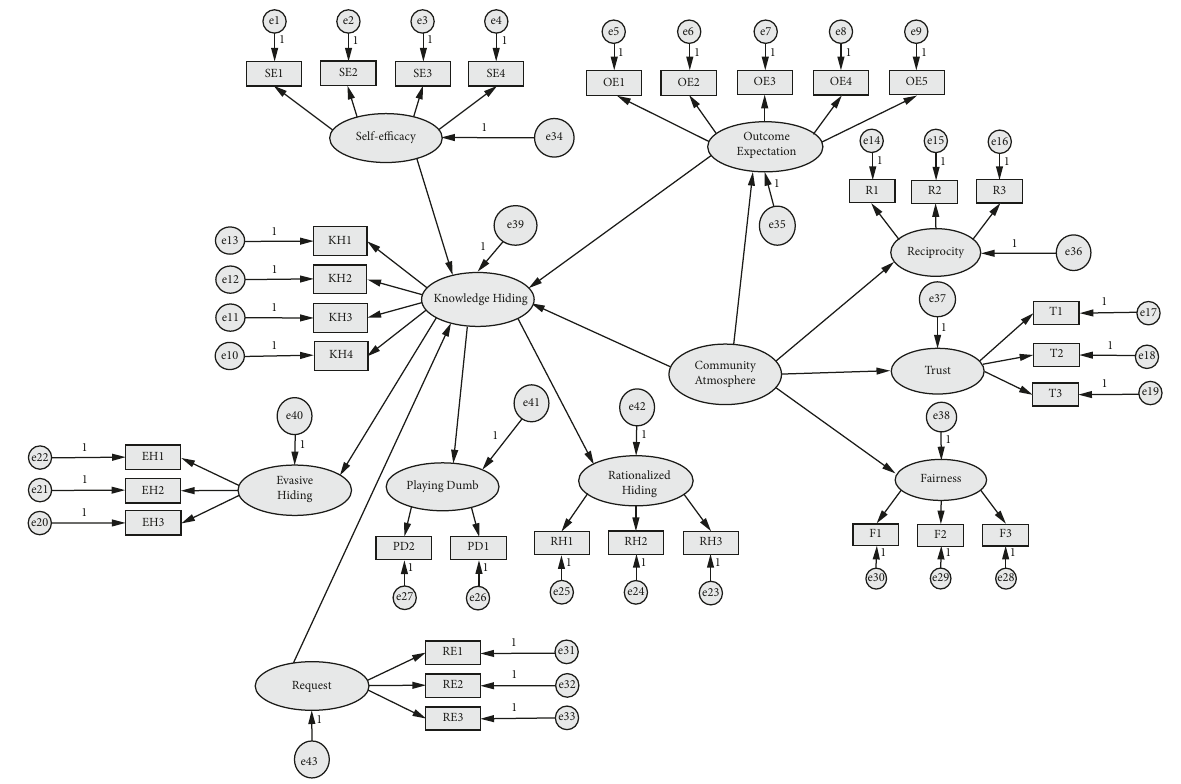
Figure 2: The structural equation Table 10: Model fitting indicators.